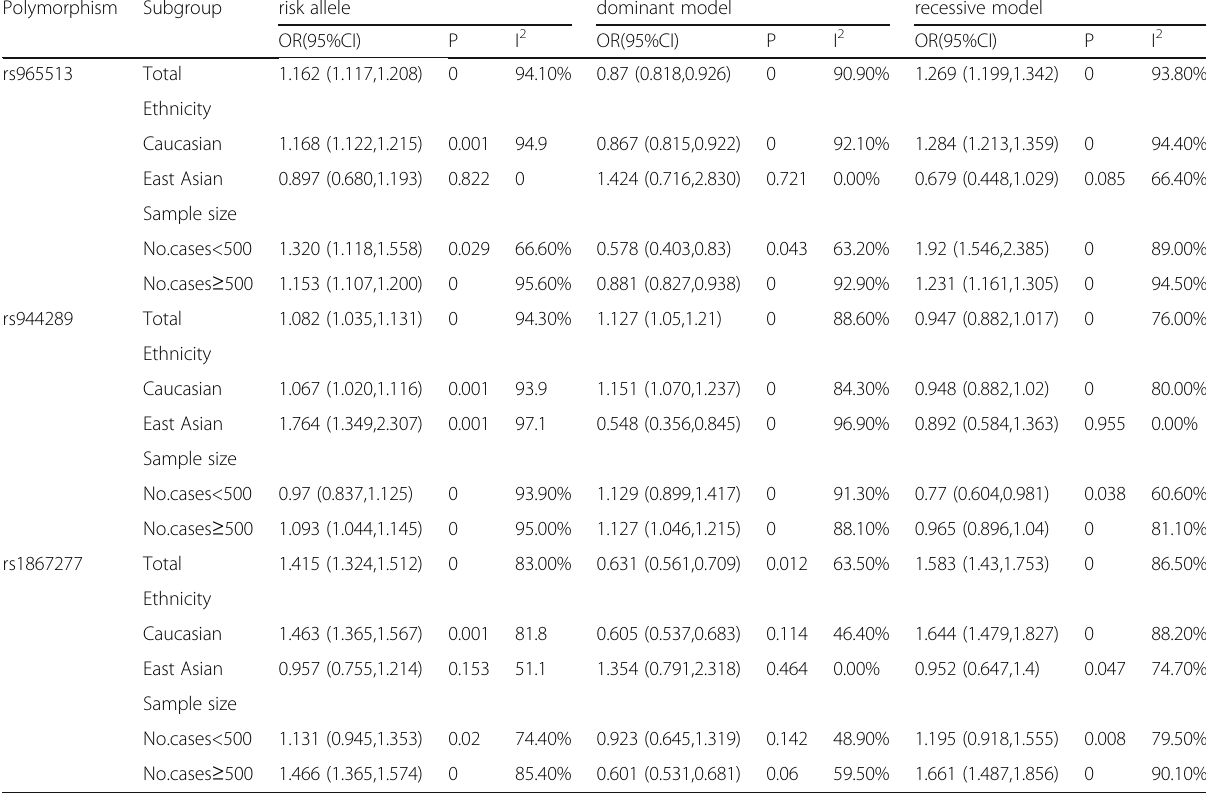
Table 2 Main results of overall and subgroups in the meta-analysis